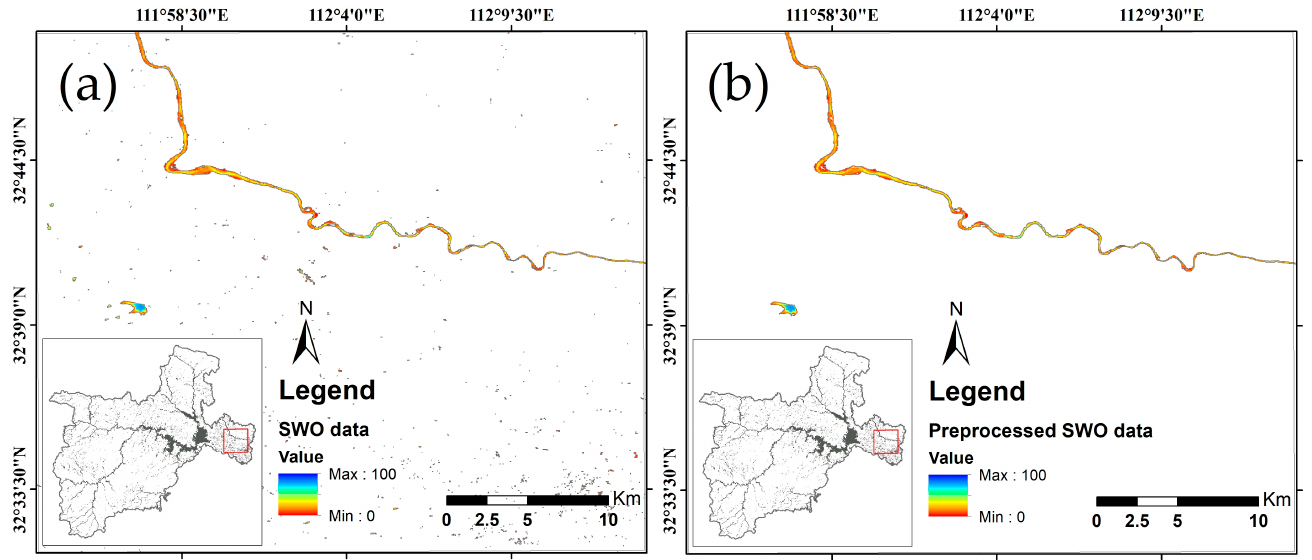
Figure 2. SWO map ( a ) and Preprocessed SWO map ( b ).